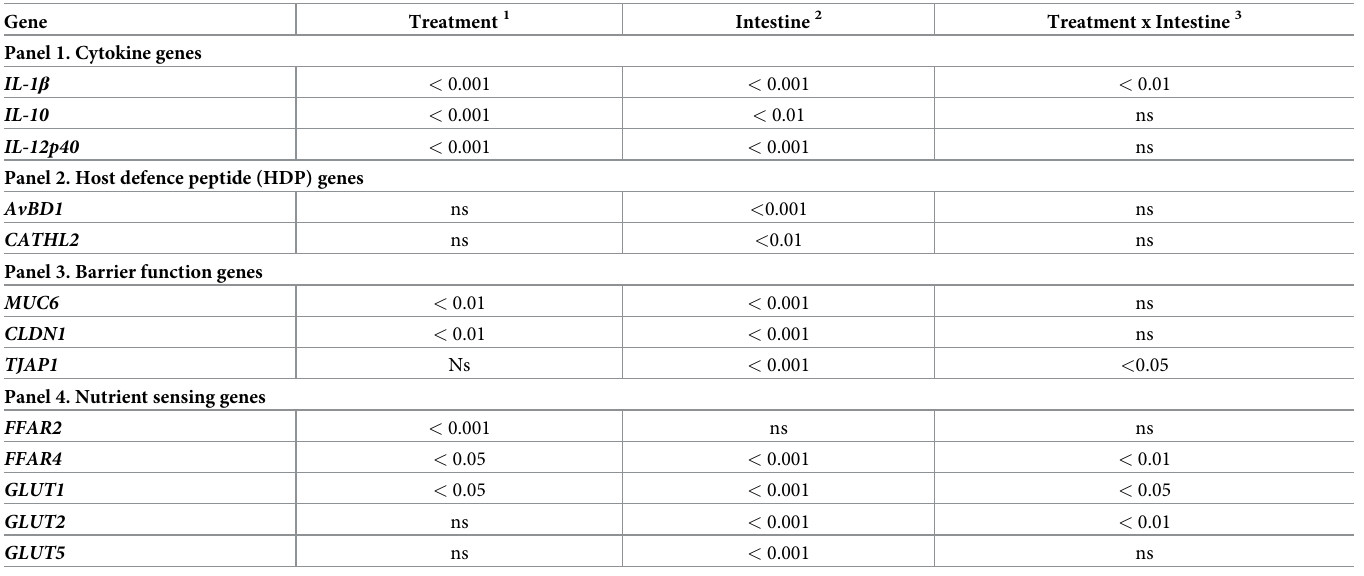
Table 3. Effects of experimental group, intestinal segment and their interaction on mRNA expression of immune, barrier function and nutrient sensing genes in chicken intestinal mucosa.